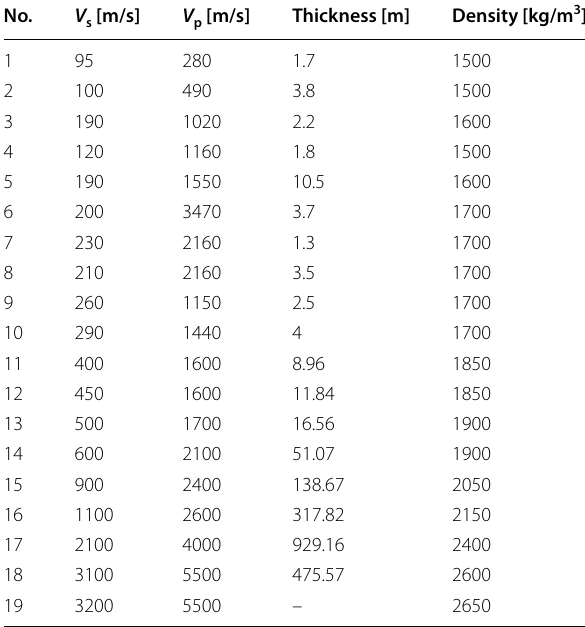
Table 4 Preferred model distributed by CBP-ESG6 No.